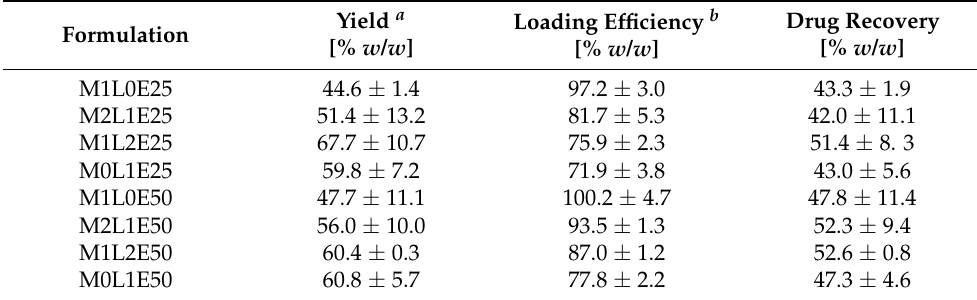
Table 2. The yields of the spray drying